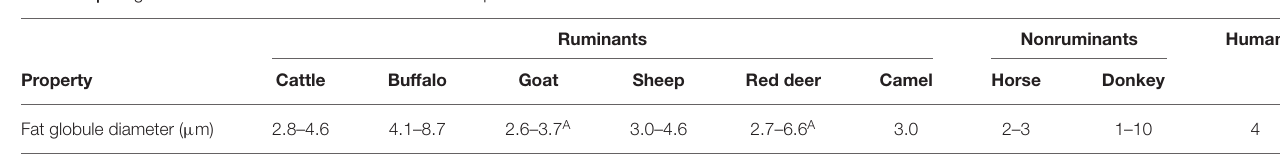
TABLE 5 | Fat globule size of milk from different mammalian species #